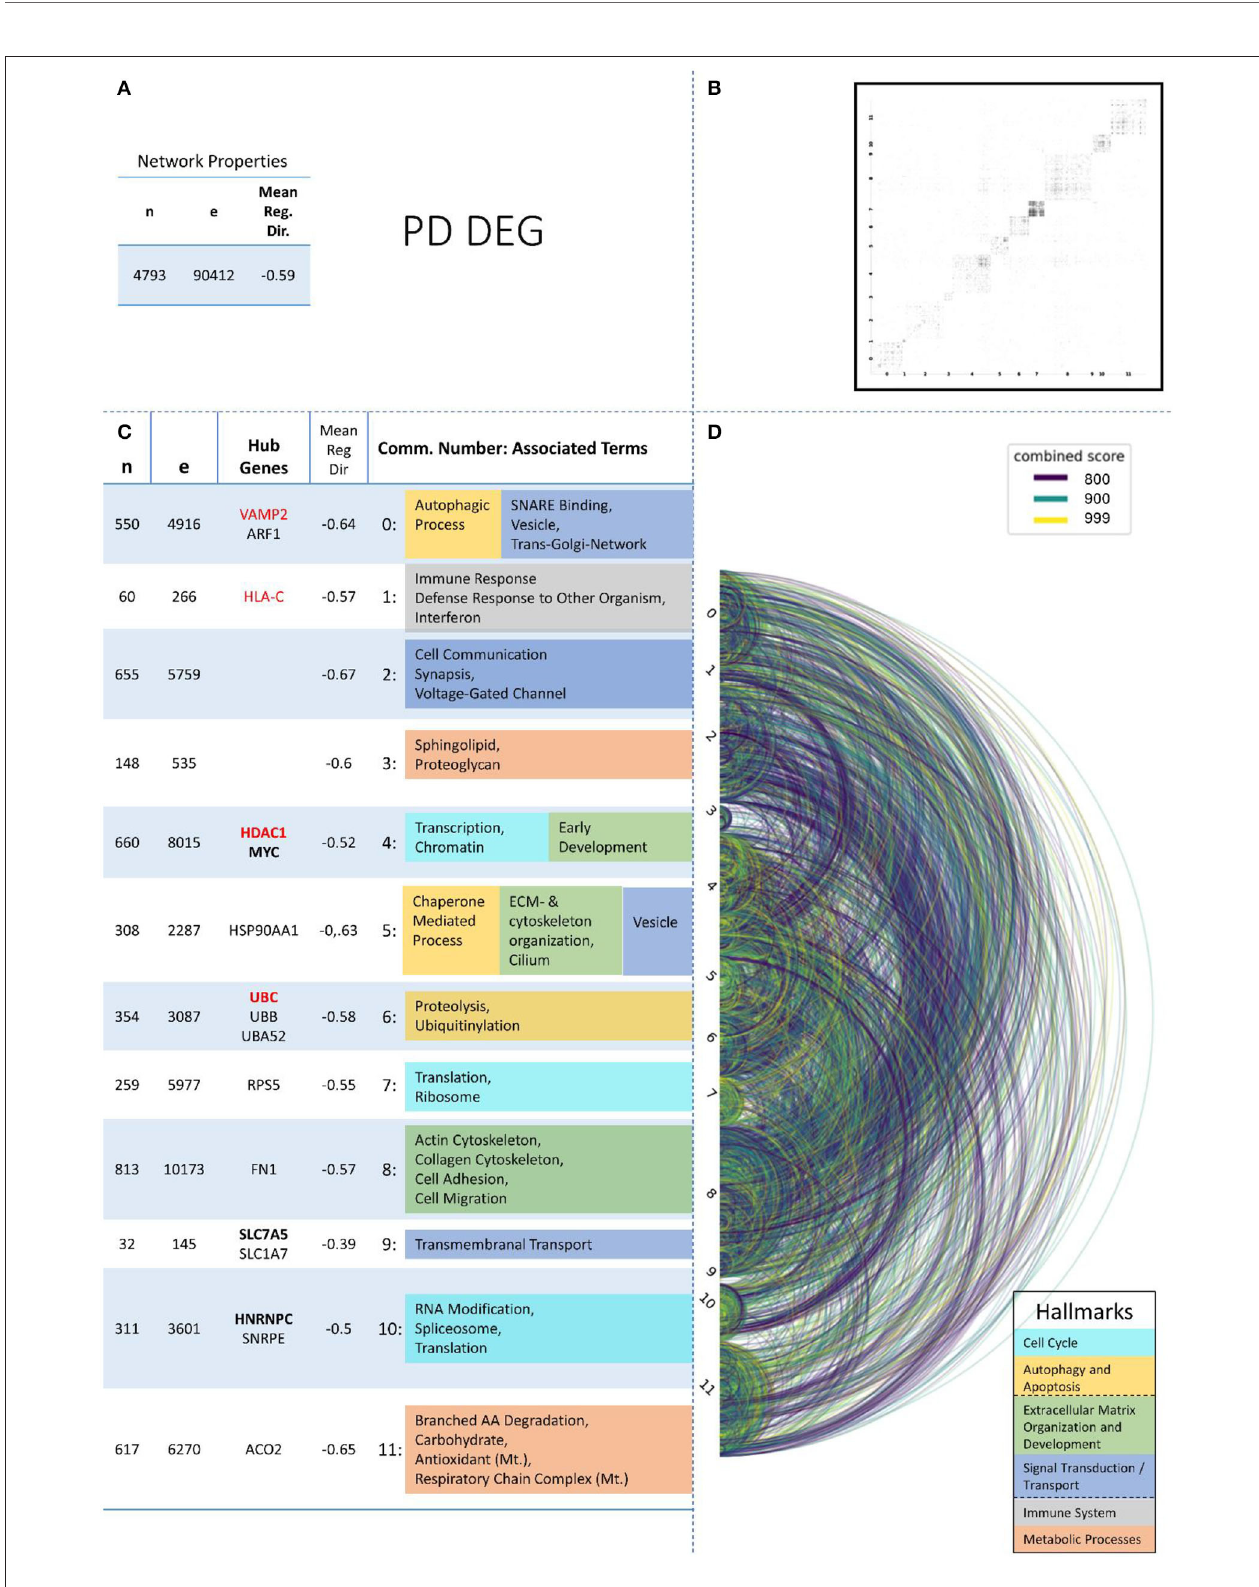
FIGURE 4 | Summarizing figure of the network analysis results of the transcriptomic layer of PD. The general properties, such as number of nodes (genes) and edges (a combined score > 400 between two nodes) of the PPI network constructed with all PD transcriptomic genes, are given in Subfigure (A) . The